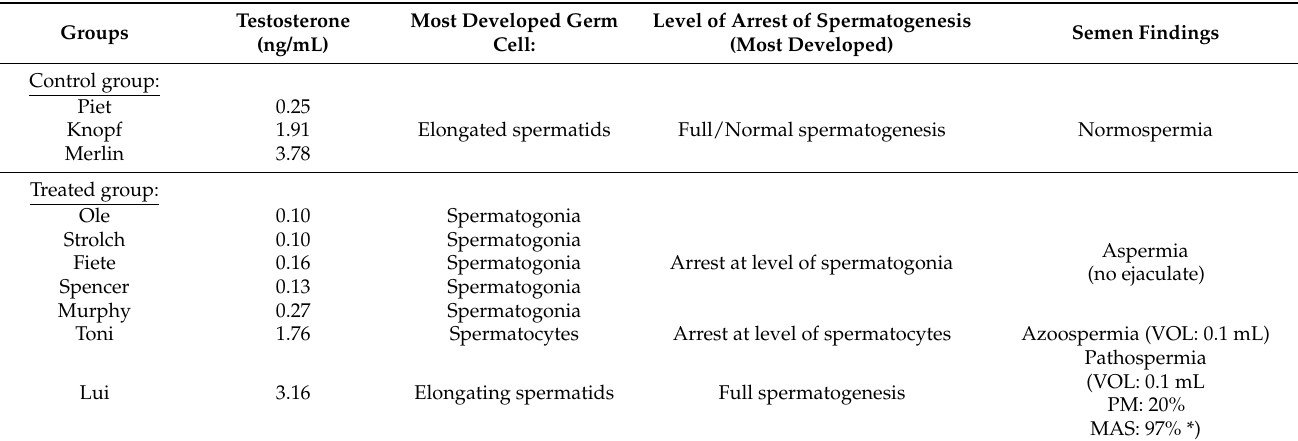
Table 1. Endocrine (testosterone, in ng/mL) and histological findings related to spermatogenesis as well as classification of semen findings in individual dogs of the control and deslorelin-treated group on the day of hemicastration.